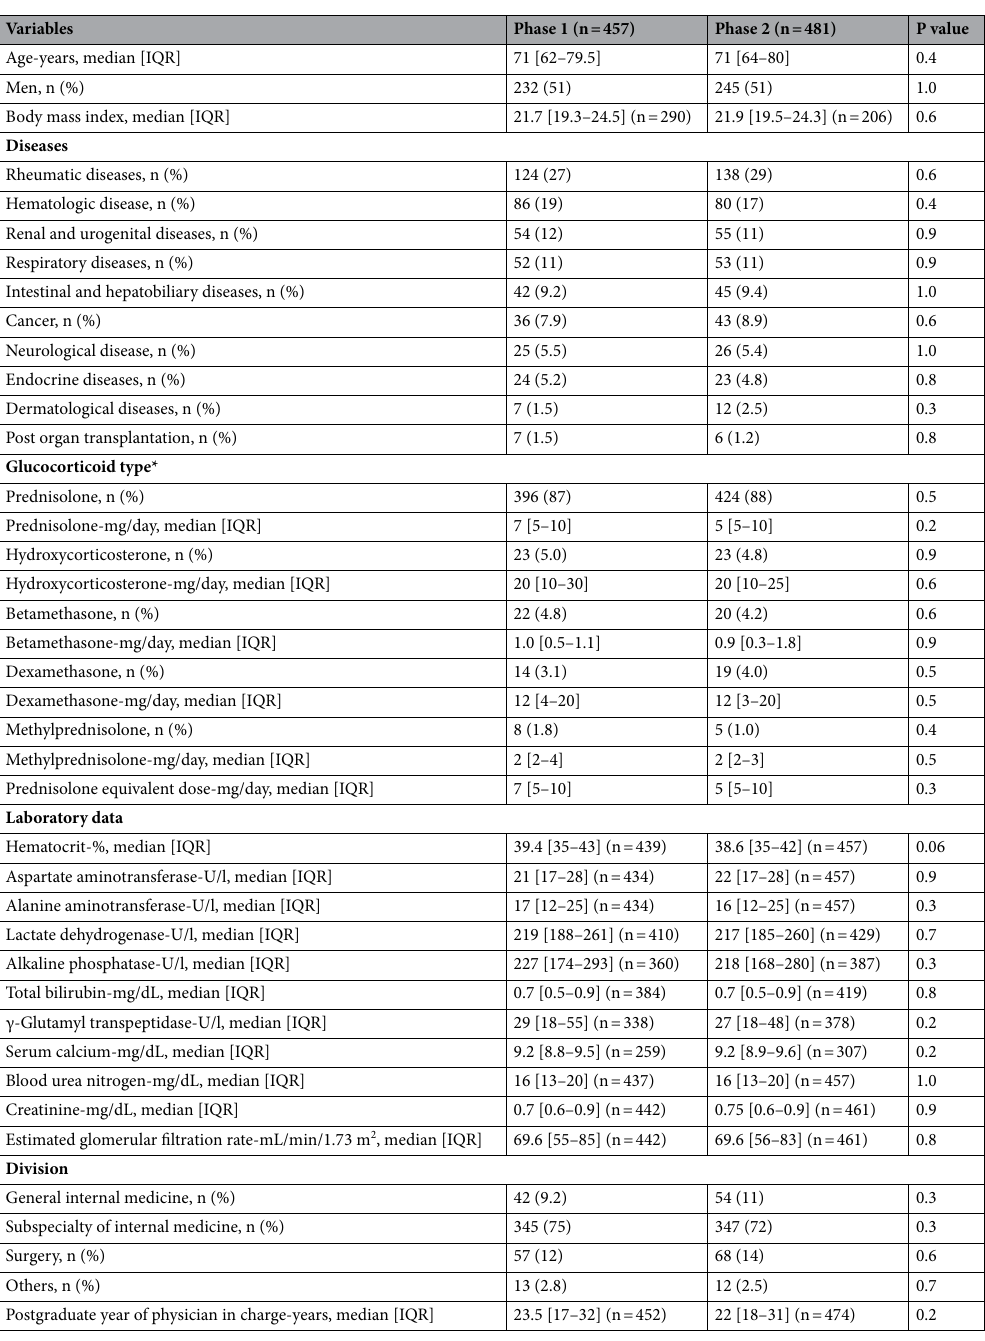
Table 1. Patient characteristics. IQR interquartile range. *Patients received multiple glucocorticoid